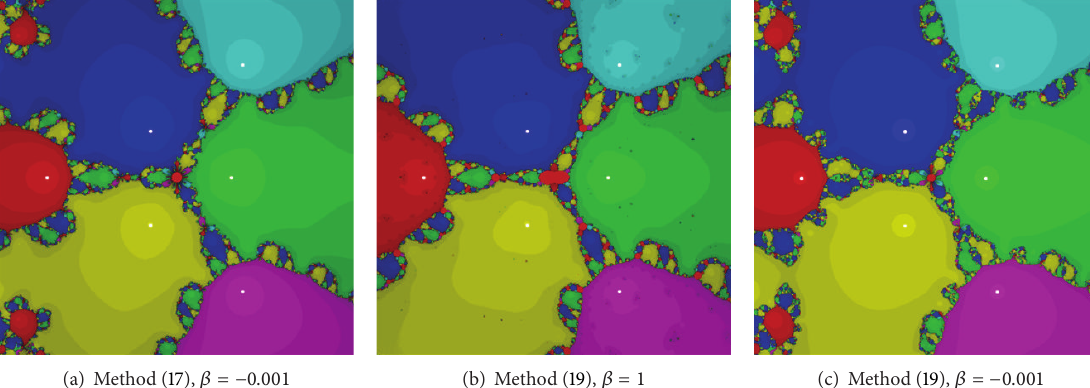
Figure 21: Basins of attraction for the test problem 2.